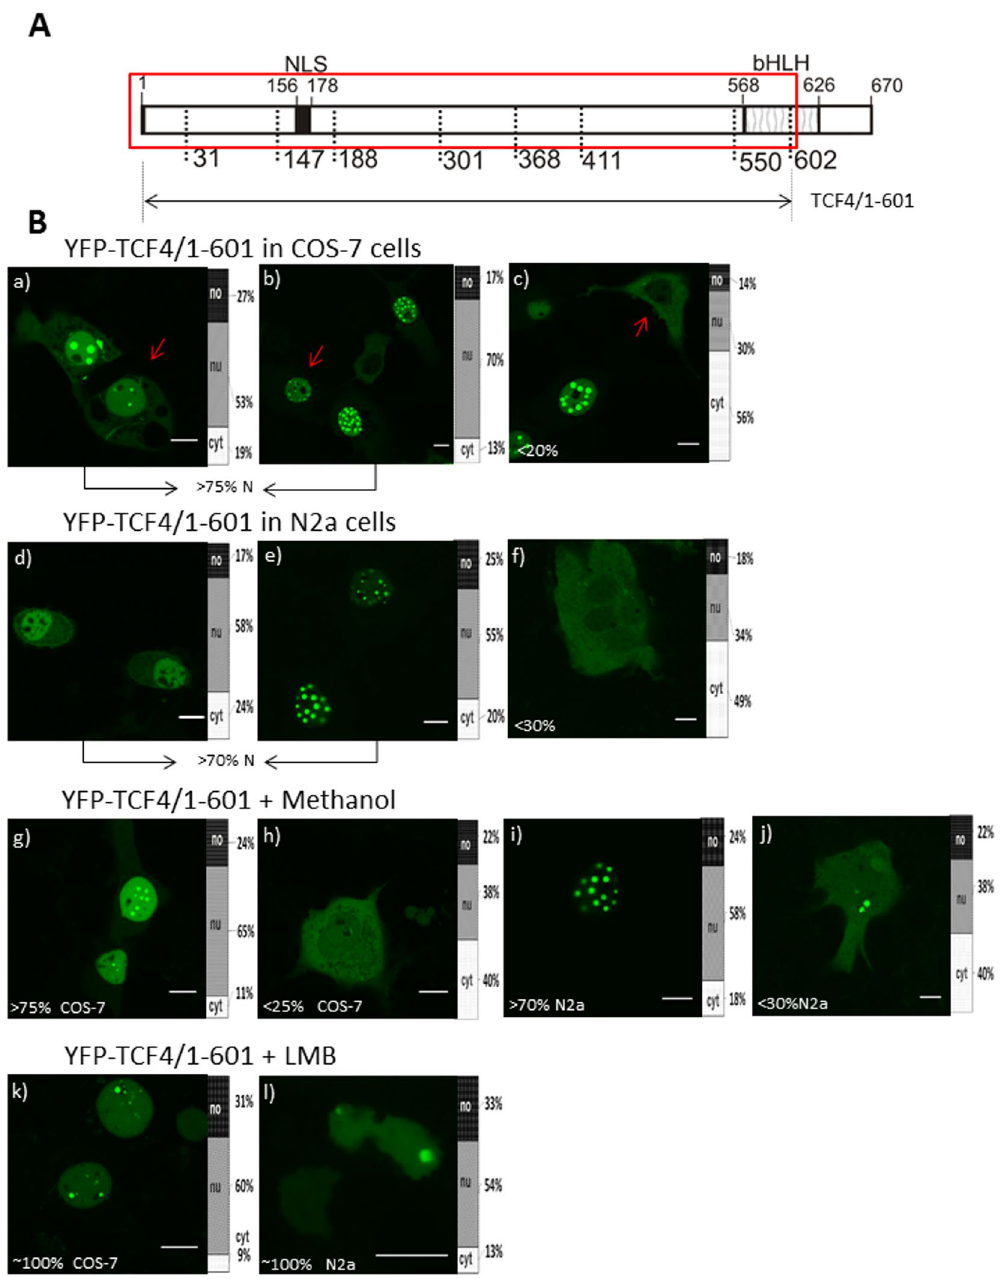
Figure 10. Hierarchy of NLS and NES signals in TCF4 ( A ) Schematic representation of TCF4 protein. Region of studied area of TCF4 is shown by the red rectangle. Expressed deletion mutant of TCF4 is depicted as an arrow. The length of each domain in the diagram is arbitrary. ( B ) Subcellular localizations of the expressed protein were analysed by confocal microscopy 20-24 h after transfecting COS-7 and N2a cells in the absence or presence of additional factors such as LMB or methanol. Representative images (single confocal plane for confocal microscopy) of subcellular distribution of the TCF4/1-601 area. Bar, 10 µ m. Ratios between mean fluorescence intensity in cytoplasmic, nuclear and nucleolar compartments are presented as an accumulated bar graph (no- nucleolus; nu- nucleus, cyt- cytoplasm). (a-c) YFP-TCF4/1-601 in COS-7 cells, (d-f) YFP-TCF4/1- 601in N2a cells (g,h) YFP-TCF4/1-601 after methanol addition in COS-7 cells, (i,j) YFP-TCF4/1-601 after methanol addition in N2a cells (k) YFP-TCF4/1-601 after LMB addition in COS-7 cells (l) YFP-TCF4/1-601 after LMB addition in N2a